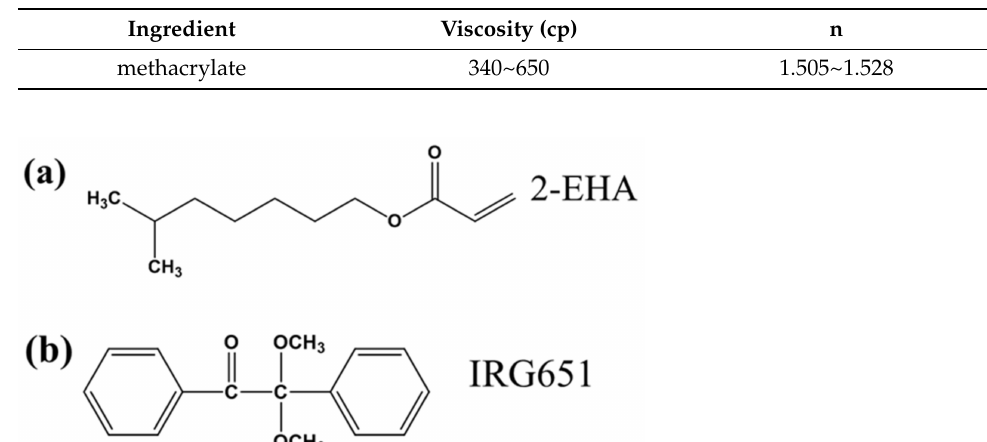
Table 1. Typical characteristics of UV64-5.